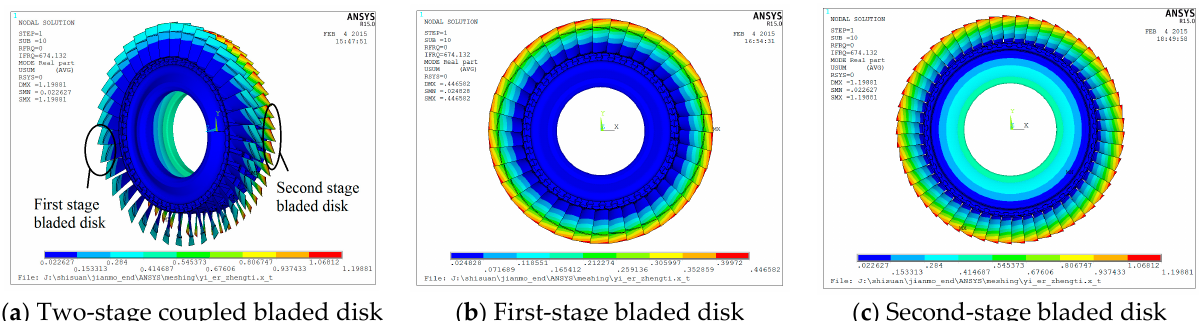
Figure 25. Coupled vibration at a natural frequency of 656.78 Hz.